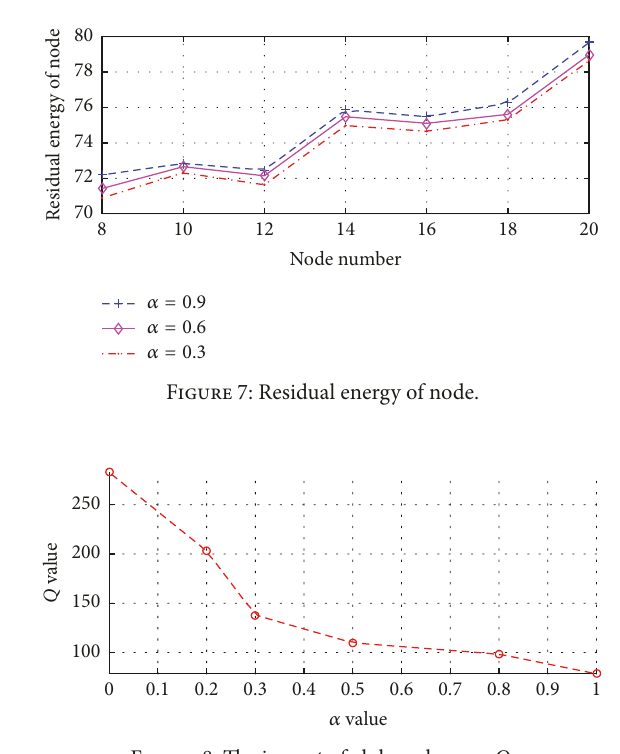
Figure 8: The impact of alpha values on